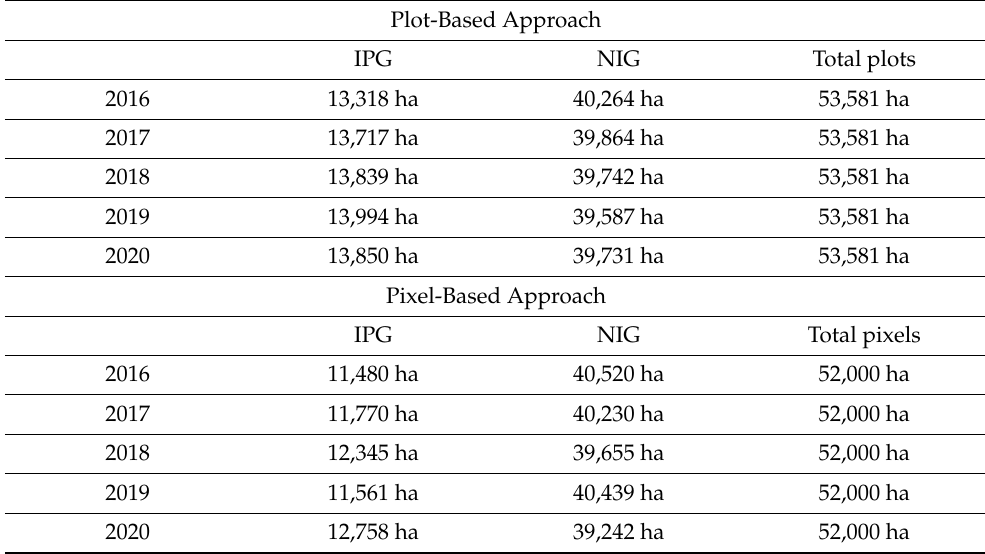
Table 5. Total surfaces obtained for IPG and NIG classes using the developed classification algorithm obtained with a plot aggregation or a pixel-based approaches. Plot-Based Approach IPG NIG Total plots 2016 13,318 ha 40,264 ha 53,581 ha 13,717